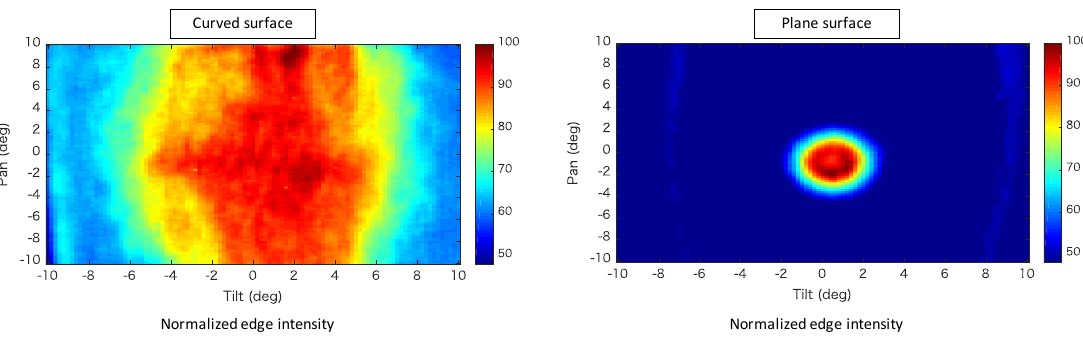
Figure 8. Colormap of the average luminance values with respect to the pan- and tilt-axis mirror angles.